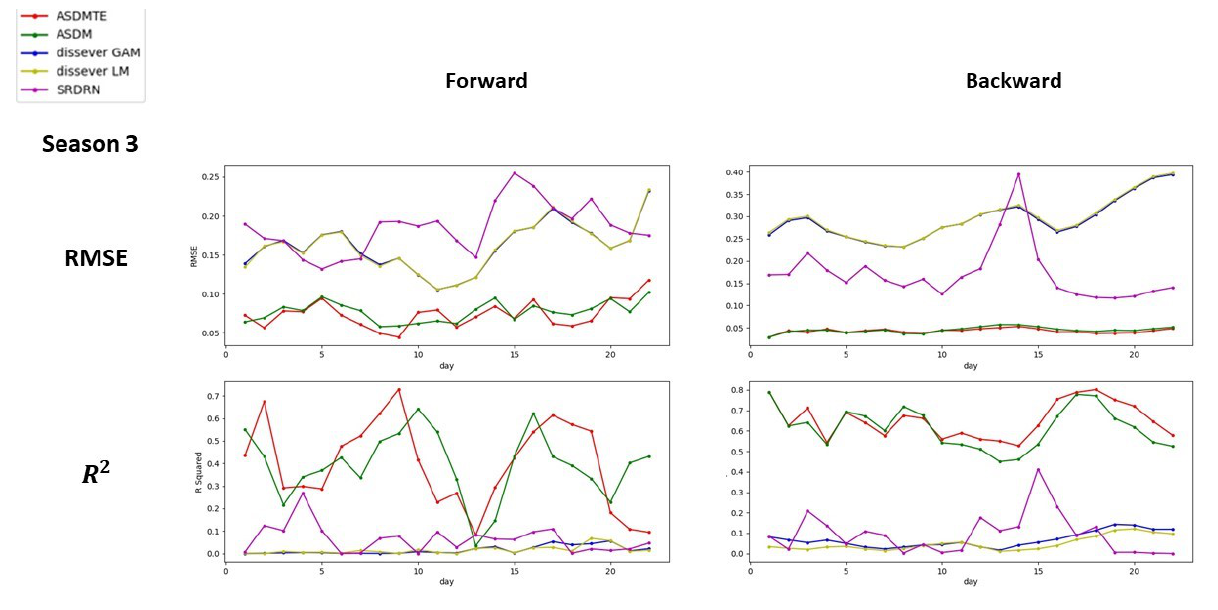
Figure A3. Downscaling performance of ASDM, ASDMTE, SRDRN, dissever GAM and dissever LM in Season 3. Please refer to Figure 4 and Section 2.2.3 for the definition of Season 3.